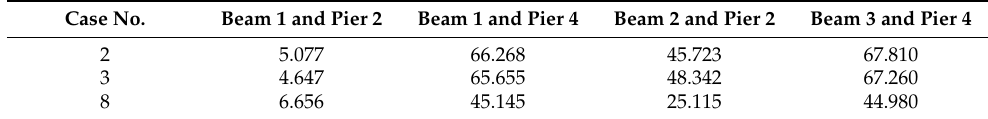
Table 8. Relative displacements of the piers and beams (mm).